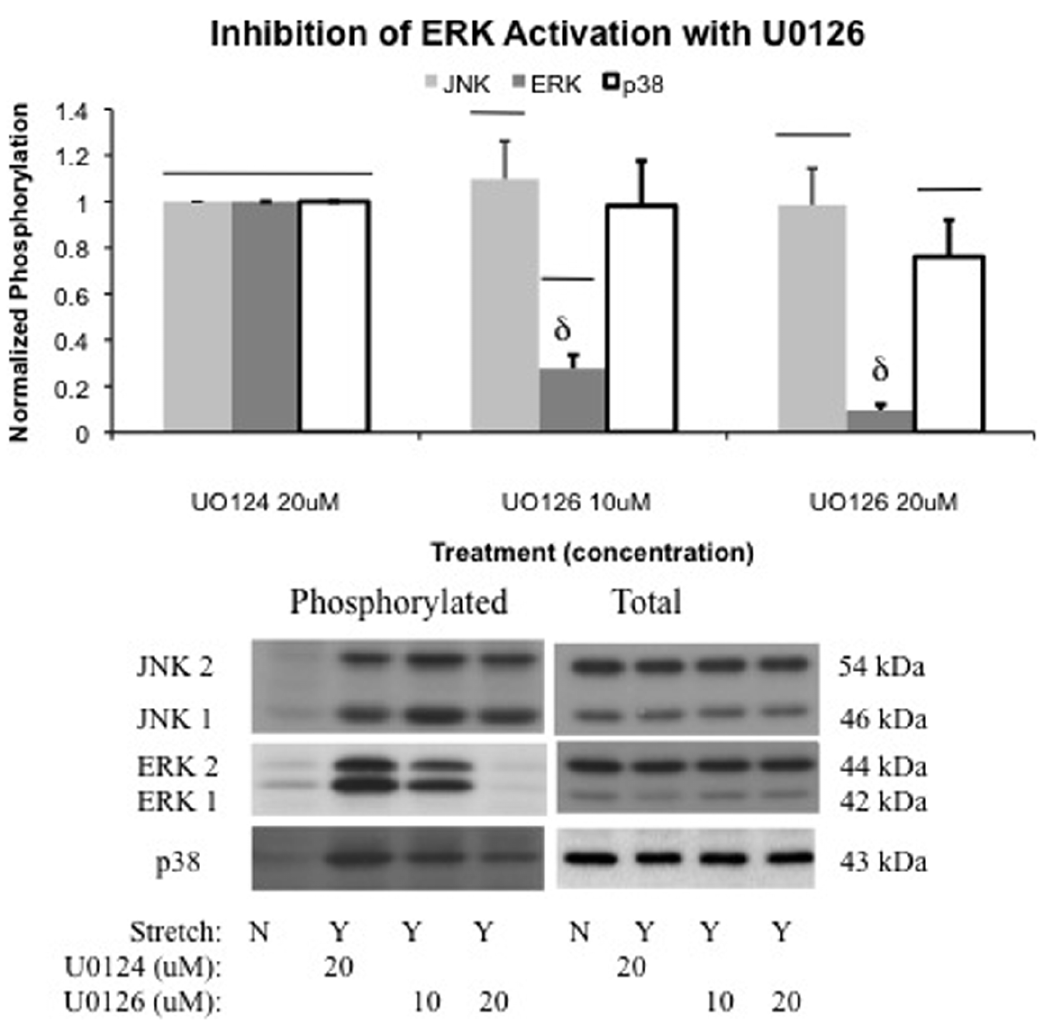
Figure 3. U0126 inhibits ERK phosphorylation. Phosphorylation levels of JNK, ERK, and p38 MAPk following treatment with the inhibitor U0126 (10 or 20 m M) or the control U0124 (20 m M) and 10 minutes of cyclic stretch at a rate of 0.25 Hz to a peak magnitude of 37% D SA normalized to stretched U0124 controls. Phosphorylation levels of all MAPks significantly increased above unstretched levels in U0124 treated wells. Following treatment with 10 or 20 m M of U0126 and 10 minutes of stretch, ERK phosphorylation was significantly reduced compared with U0124 treatment and stretch. Only treatment with 20 m M of U0126 eliminated significant increases in ERK above unstretched levels. Significance is defined as p , 0.05, and is depicted with (—) compared to unstretched, and ( d ) compared to U0124 treated. Representative western blots of phosphorylated and total MAPks with each treatment are also presented.